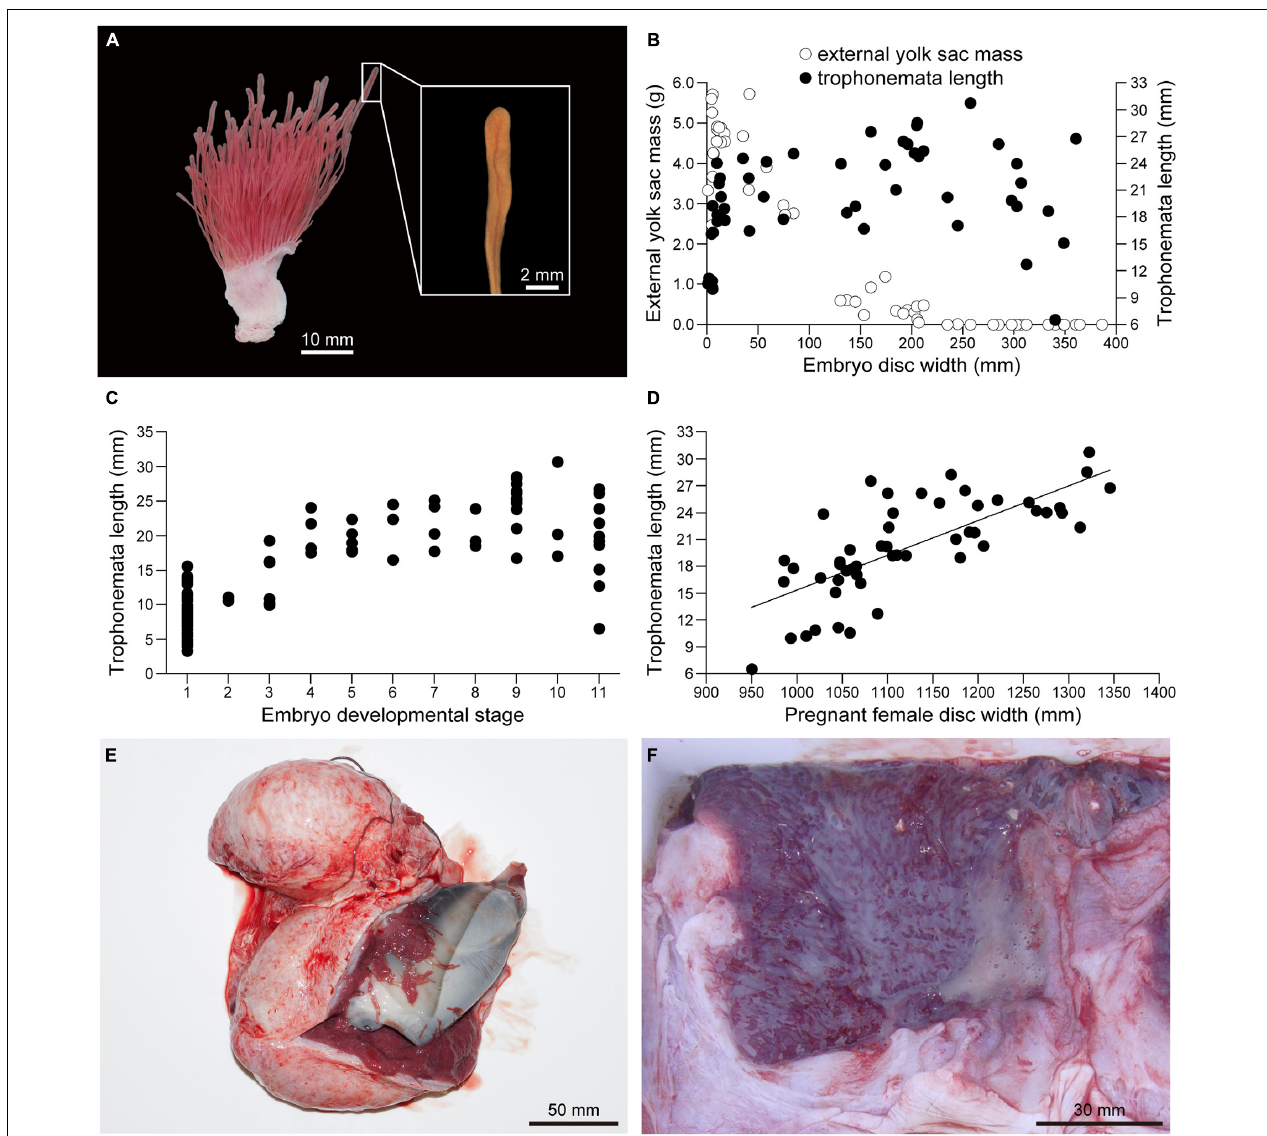
FIGURE 11 | Embryonic yolk consumption and uterine trophonemata of Aetobatus narutobiei . (A) The uterine mucosa with trophonemata Gross appearance of the uterine wall and mucosa with trophonemata representative of a female with stage 11 embryos. (B) The relationship between embryo disc width, trophonemata length and the external yolk mass and (C) embryo development stage versus trophonemata length. (D) The relationship between the pregnant female disc width and trophonemata length. (E) Stage 9 embryo within the uterus. (F) Histotroph (pale yellow material) in the uterus of a female with late term, stage 11